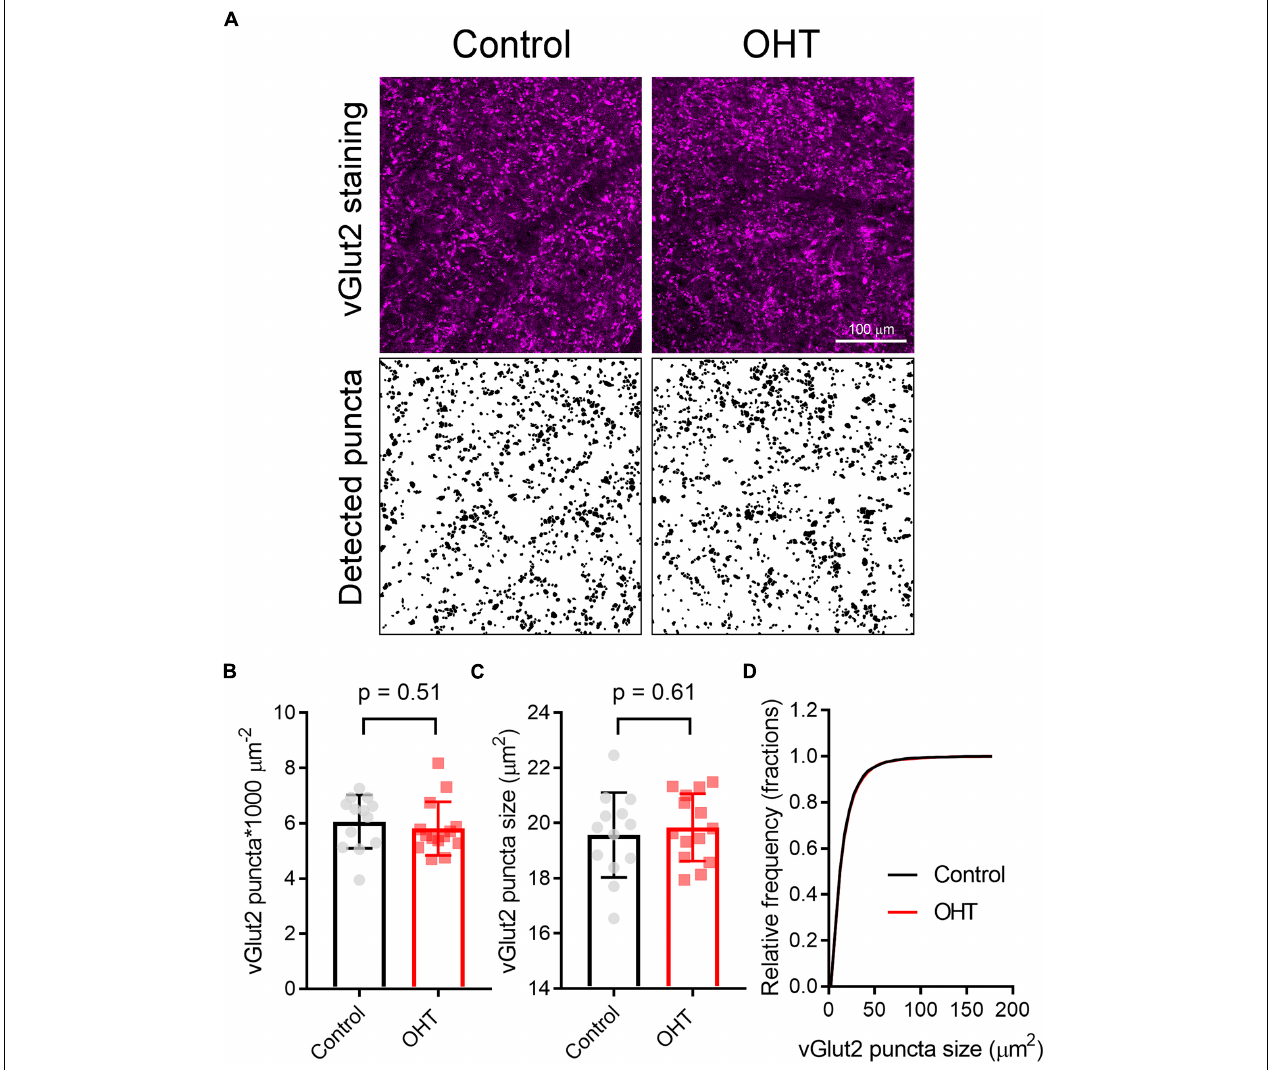
FIGURE 8 | Five weeks modest OHT does not alter vGlut2 staining in the dLGN. (A) 2-photon images of a 1.5 micron optical section of dLGN stained for vGLut2, which marks RGC axon terminals in control and OHT conditions. Lower panels show vGlut2 puncta that were automatically detected in ImageJ. (B–D) Neither the density nor the size of vGlut2 puncta differed between control and OHT dLGN. The density and size of puncta for each brain slice are plotted individually and the mean + SD is plotted in the bar graph (B,C) . (D) The cumulative distribution of 300 detected vGlut2 puncta per brain slice was nearly identical for control and